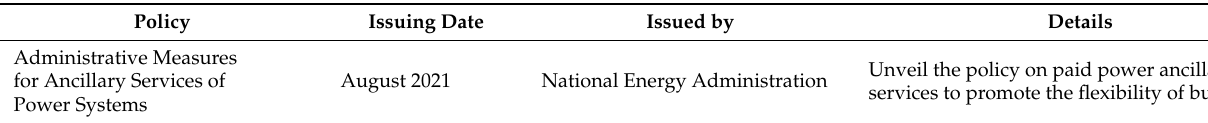
Table 1. Policies in favor of the development of LVDC